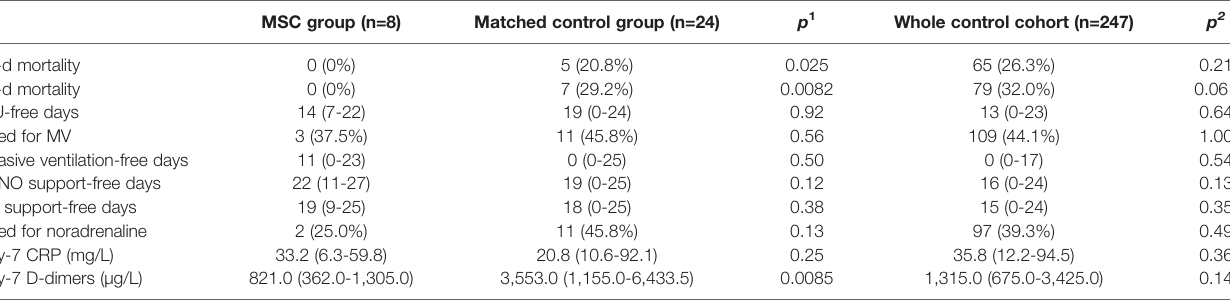
TABLE 2 | Clinical and biological outcomes.